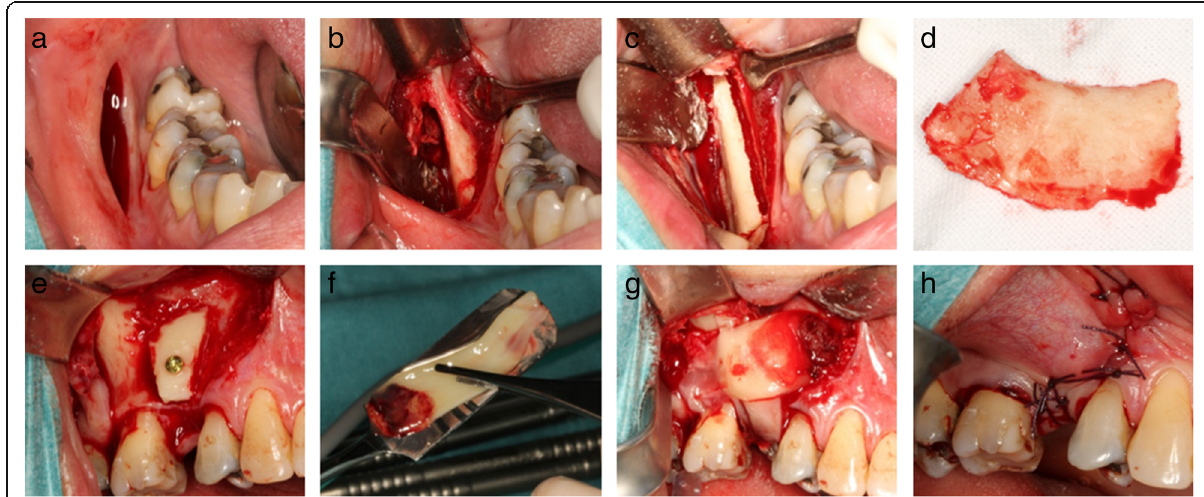
Fig. 1 Intraoperative photos illustrating bone harvesting and lateral bone augmentation in the PRF group. Initially, an incision is made at the lateral aspect of the posterior part of the mandibular corpus ( a ) followed by exposing the mucoperiosteal flap ( b ), before making the osteotomy line ( c ). The bone block ( d ) is then retrieved before adjusted to the contour at the recipient site and fixated with an osteosynthesis screw ( e ). Autogenous bone graft particles are packed around the graft before covering the grafted area with three PRF membranes ( f and g ). Finally, tension-free primary wound closure is performed before suturing ( h